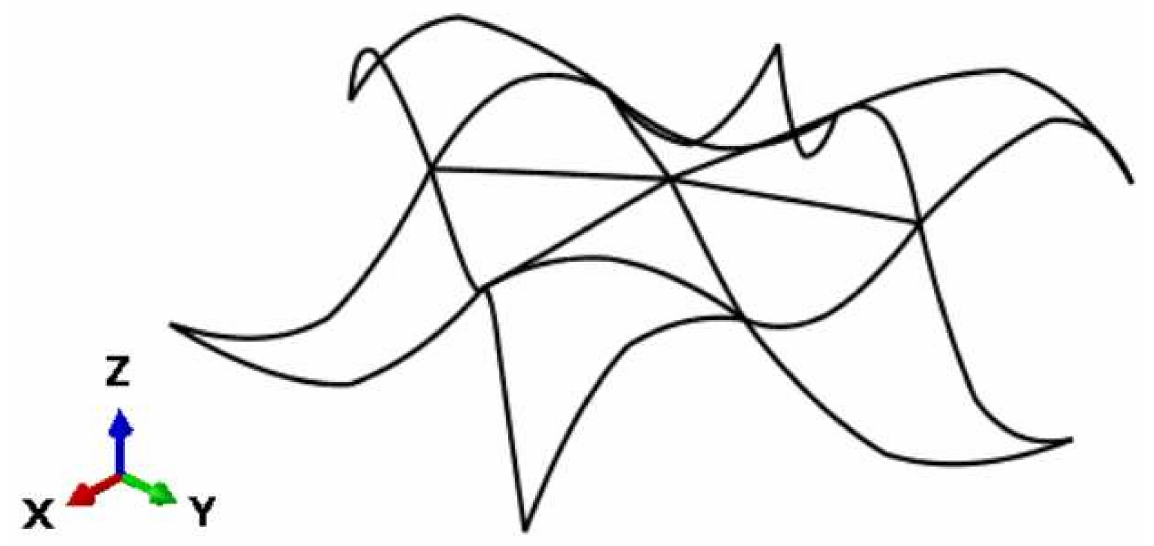
Figure 6. Dome 2—real part of the first nonlinear eigenvector.